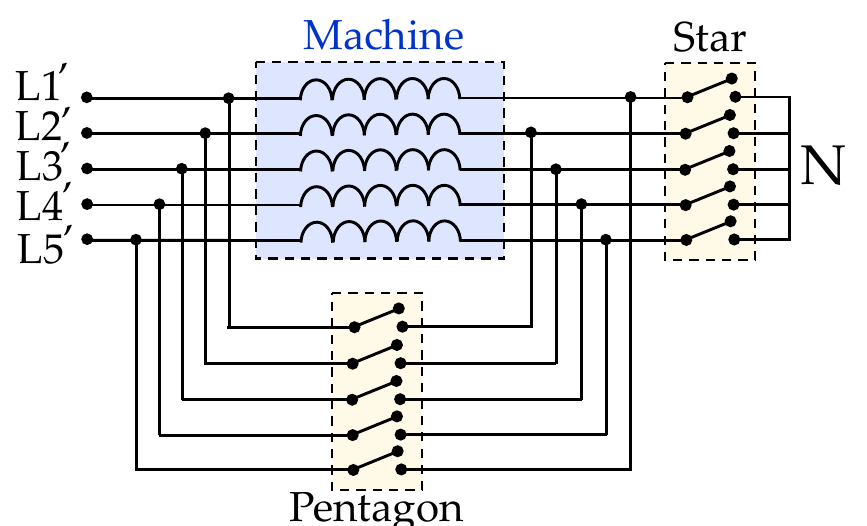
Figure 16. Five-phase topology with bidirectional switches to alternate between star and pentagon stator connections